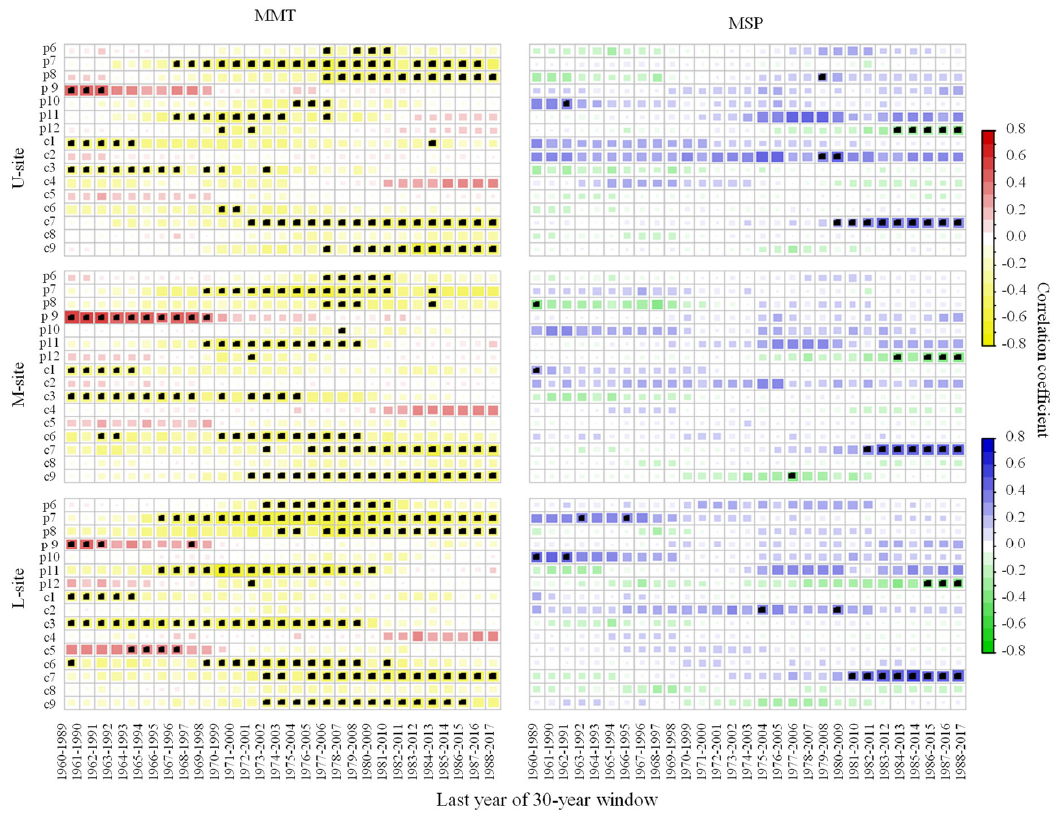
Figure 4. Temporal stability of the correlation between monthly temperature and precipitation and Picea wilsonii growth response (30-year period). Darker colour and larger box indicate higher R values ( p < 0.05). Three sample sites were L-site at 2020 m, M-site at 2090 m, and U-site at 2220 m. The letter p before months indicates the months of previous year, and letter c indicates the months of current year. MMT, Monthly mean air temperature; MSP, Monthly sum of precipitation.